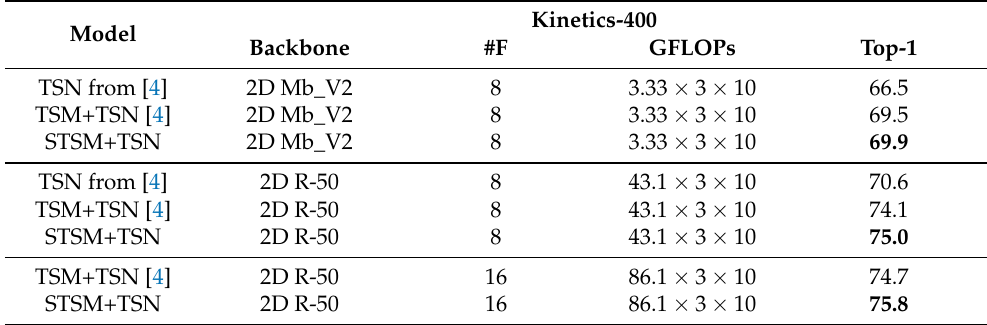
Table 4. Comparison of STSM embedded in different backbones and different number of input frames on the validation set of the Kinetics-400